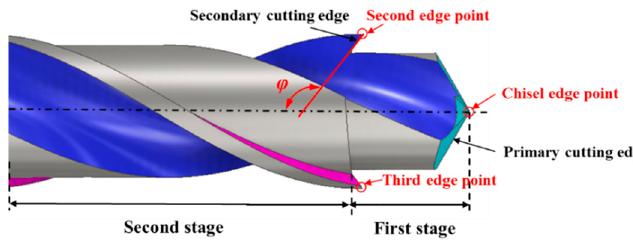
Figure 3. Schematic of the novel three-point step drill.